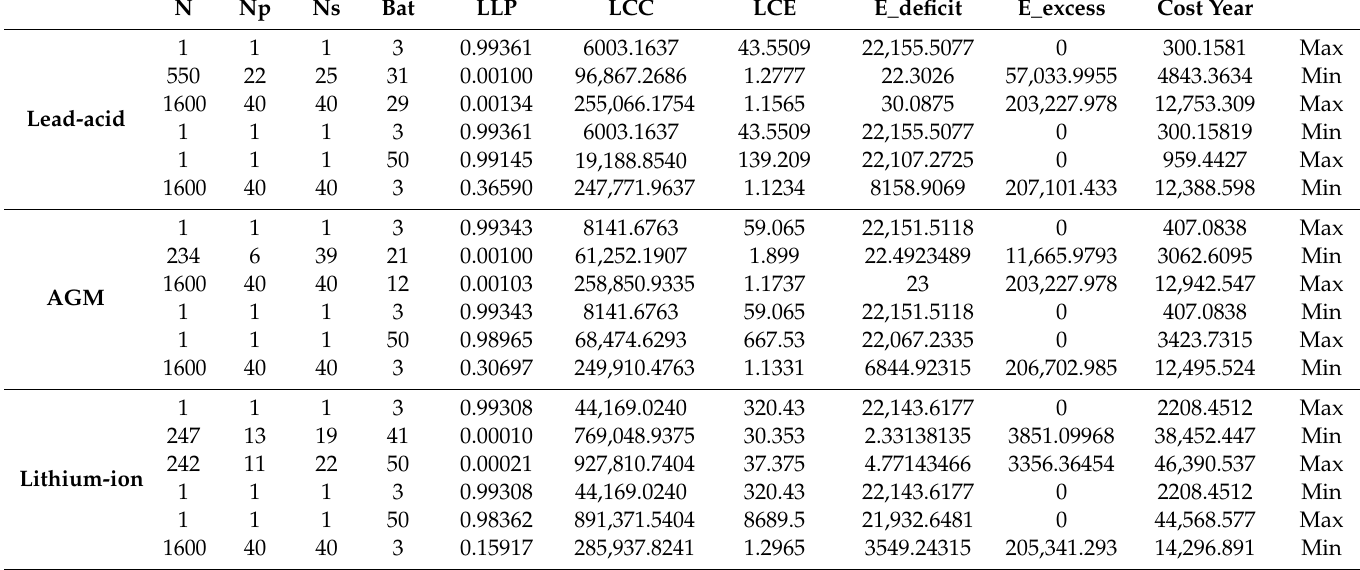
Table 6. Minimum values and maximum values of loss of load probability (LLP), life cycle cost (LCC), and levelized cost of energy (LCE) were found by the numerical method for three types of storage